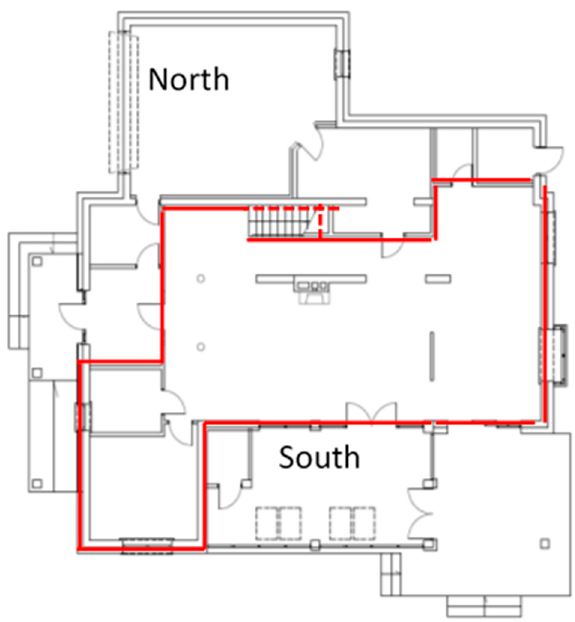
Figure 3. A plan of the first floor of the considered house, main living space area is delimited by red lines.